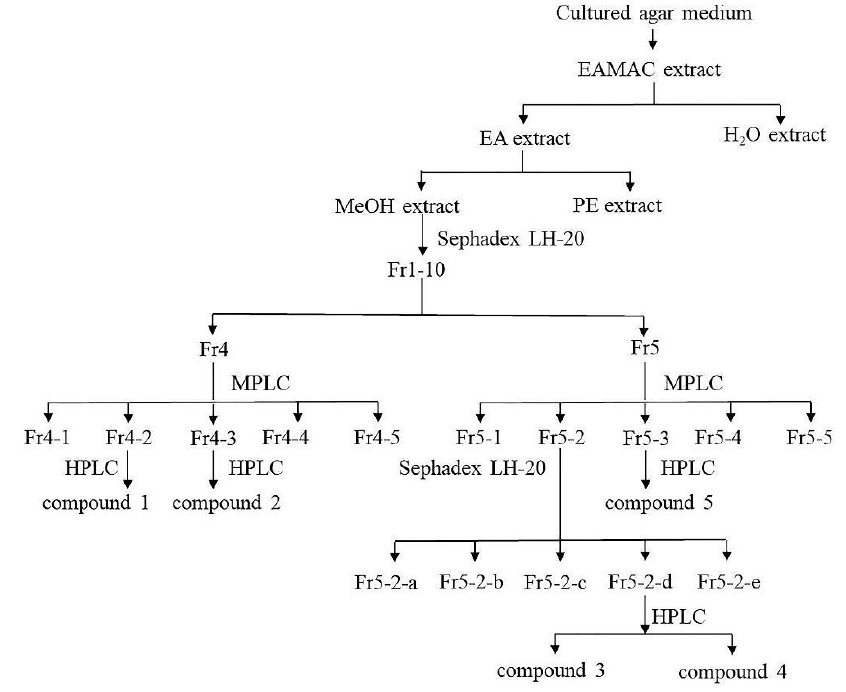
Figure 1. Isolation process of compounds 1 to 5.